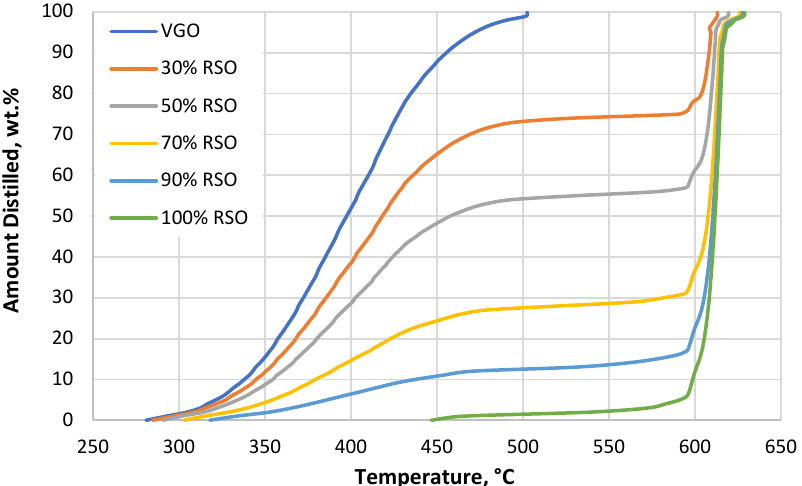
Figure 1. Simulated distillation (SIMDIS) curves of all the used feedstock materials. VGO is the feedstock without added RSO; 30%, 50%, 70%, and 90% RSO are the blends containing 70%, 50%, 30%, and 10% VGO, respectively; and 100% RSO is pure rapeseed oil. The measurement was performed according to ASTM D7169 [25].